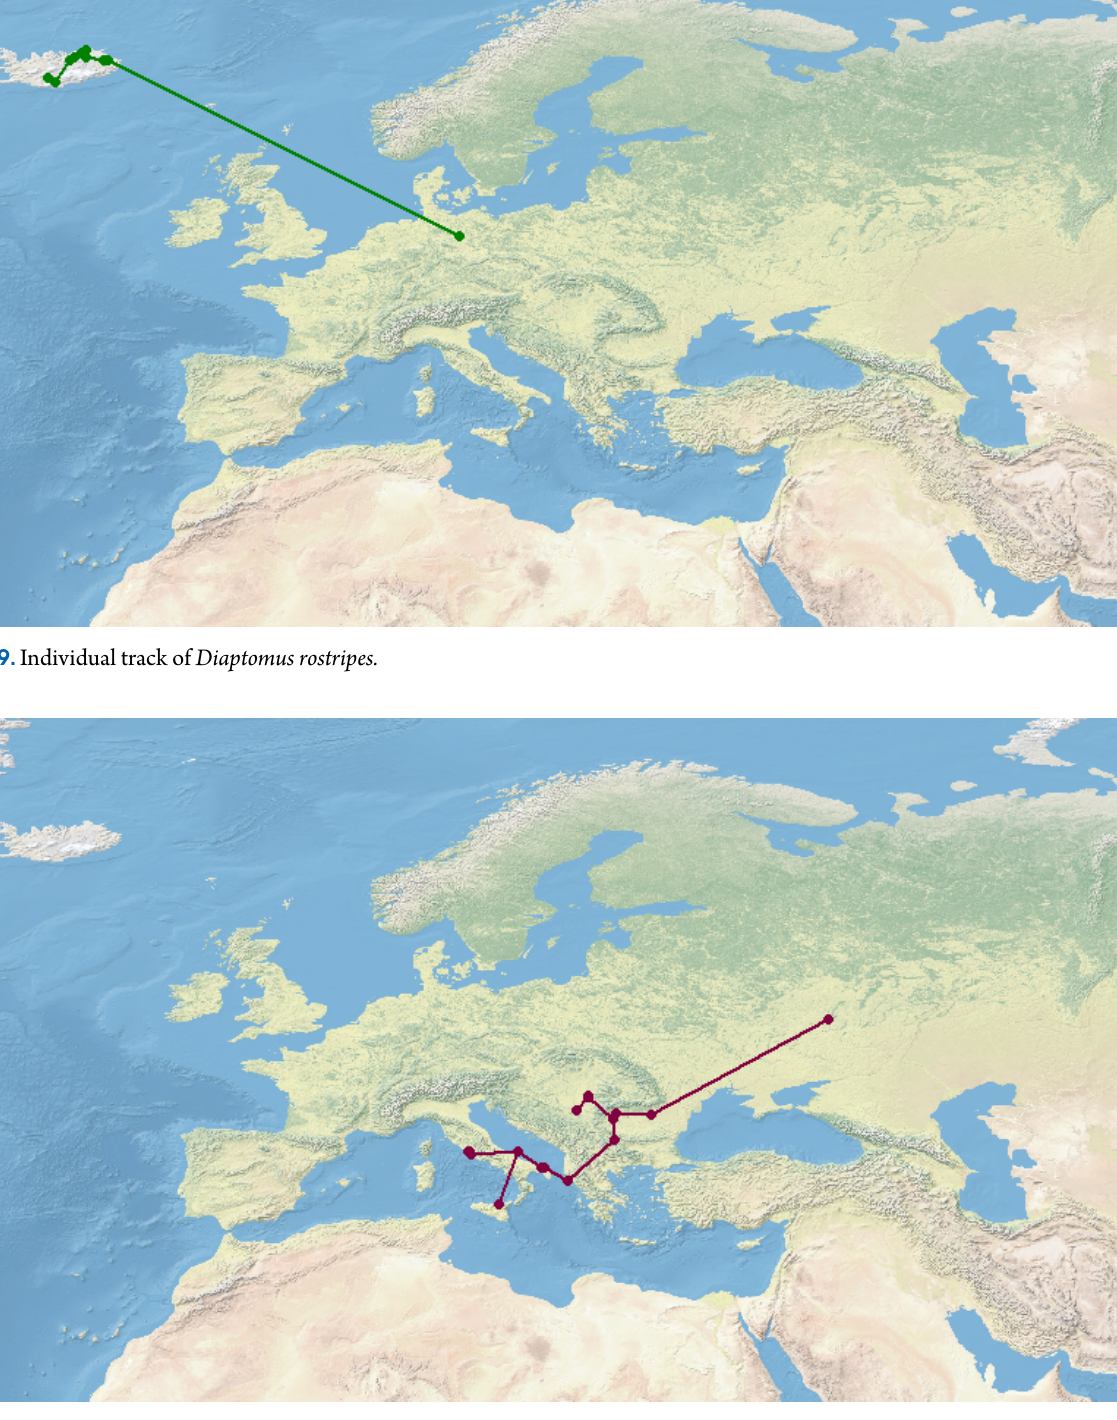
Figure 10. Individual track of Diaptomus